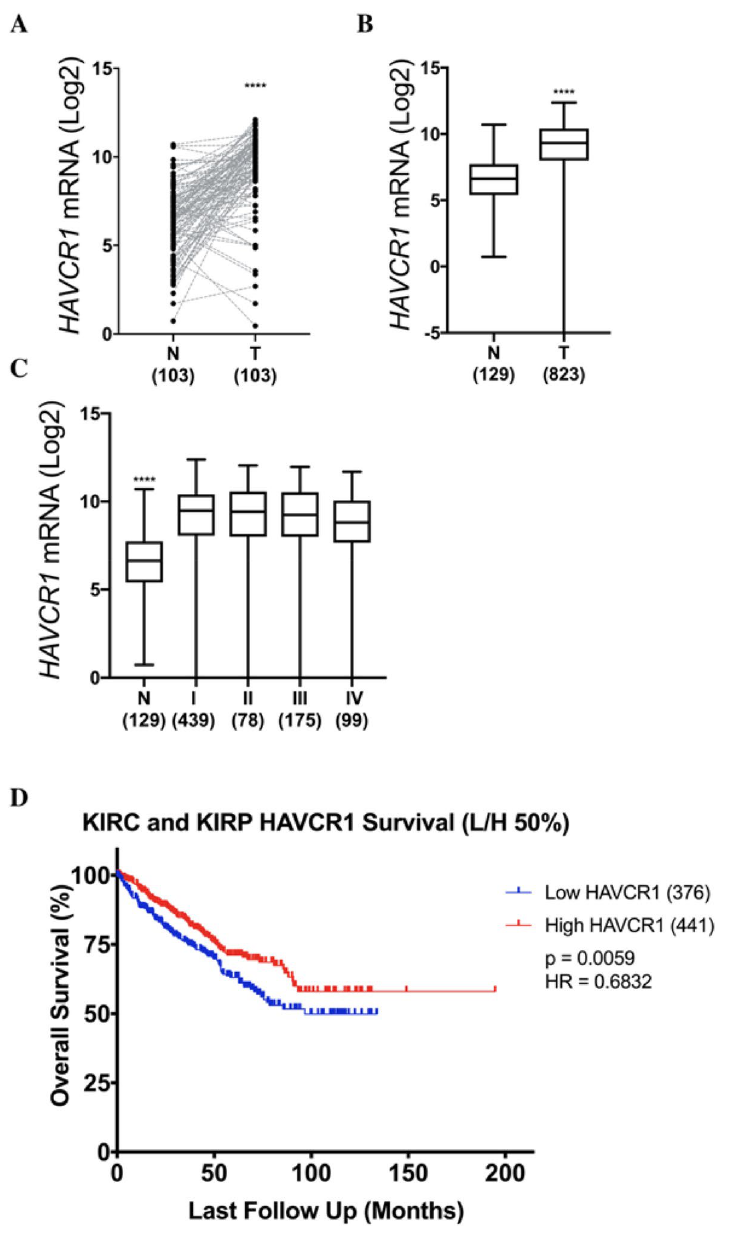
Figure 5. HAVCR1 (KIM-1) expression is upregulated in RCC tumours and predicts improved overall of patient with Clear Cell and Papillary RCC. ( A ) Paired comparison of adjacent tissue vs matched patient tumour tissues reveals increased HAVCR1 mRNA expression in tumour tissues (****p < 0.0001; Normality and Lognormality statistical analysis). ( B ) Non-paired comparison of adjacent tissues vs non-matched patient tumour tissue reveals increased HAVCR1 (KIM-1) mRNA expression in tumour tissues (****p < 0.0001; Mann– Whitney t test). ( C ) RCC tumour stages vs adjacent tissues reveals increased HAVCR1 mRNA expression in both early and late stage RCC (****p < 0.0001; Kruskal–Wallis statistical analysis). ( D ) Overall patient survival vs HAVCR1 (KIM-1) mRNA expression using 50% low/high expression cut-offs reveals increased overall survival in patients with increased HAVCR1 (**p = 0.0059; Kaplan–Meier statistical